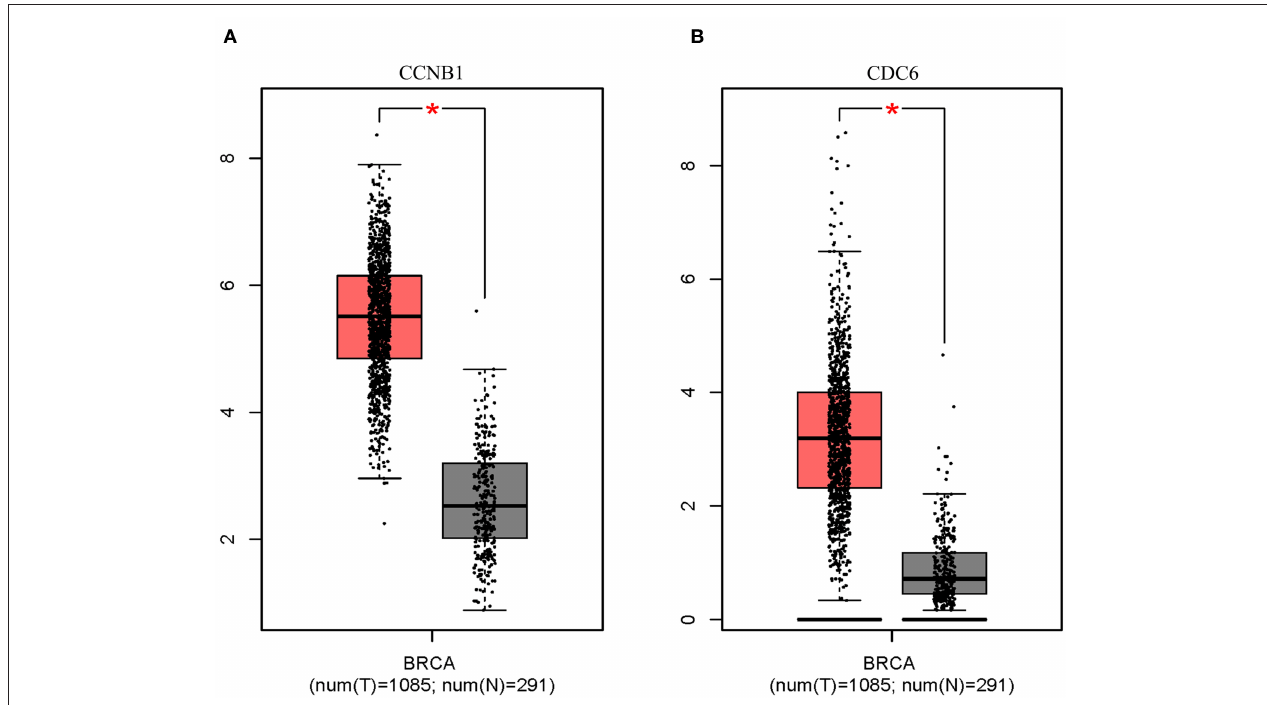
FIGURE 7 | Expression on Box Plots of CCNB1 (A) and CDC6 (B) . Significant difference in expression was set to * p < 0.01 vs. Normal